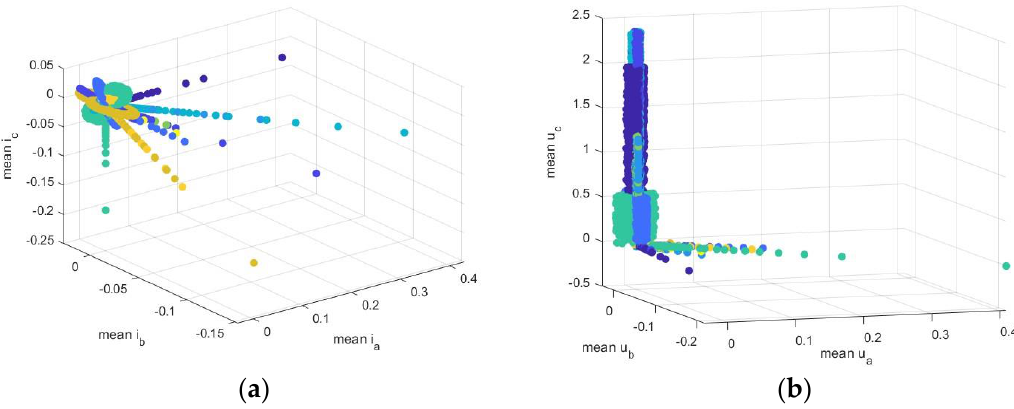
Figure 9. Dependence of average values of the ( а ) currents 𝑖 𝑎 , 𝑖 𝑏 , 𝑖 𝑐 and ( b ) voltages 𝑢 𝑎 , 𝑢 𝑏 , 𝑢 𝑐 .